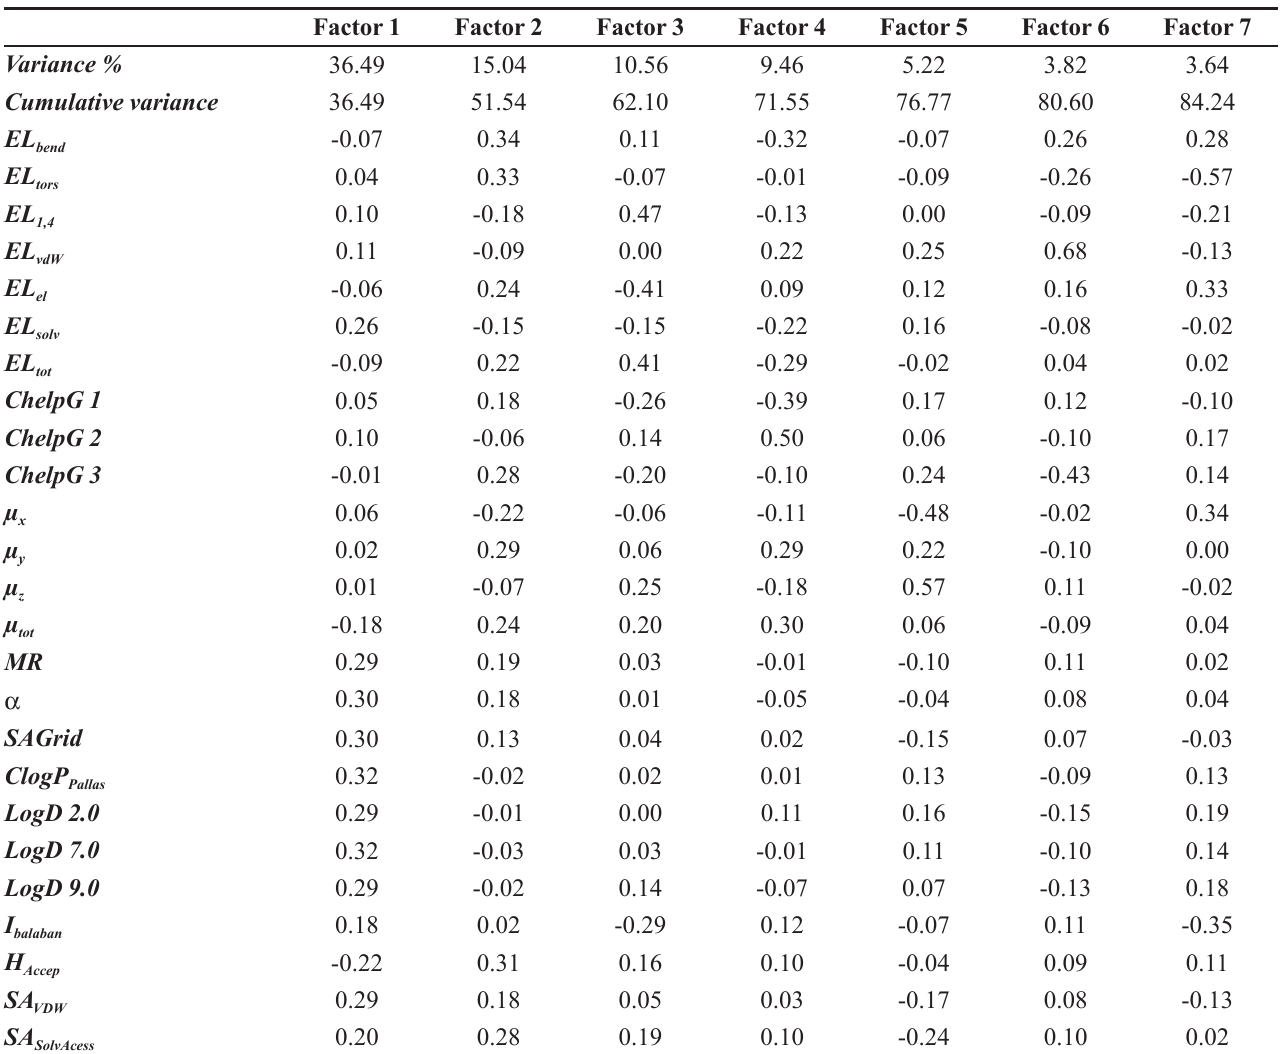
TABLE IV - Principal component analysis runs for 93 samples and 25 independent variables. The loadings of independent variables are listed